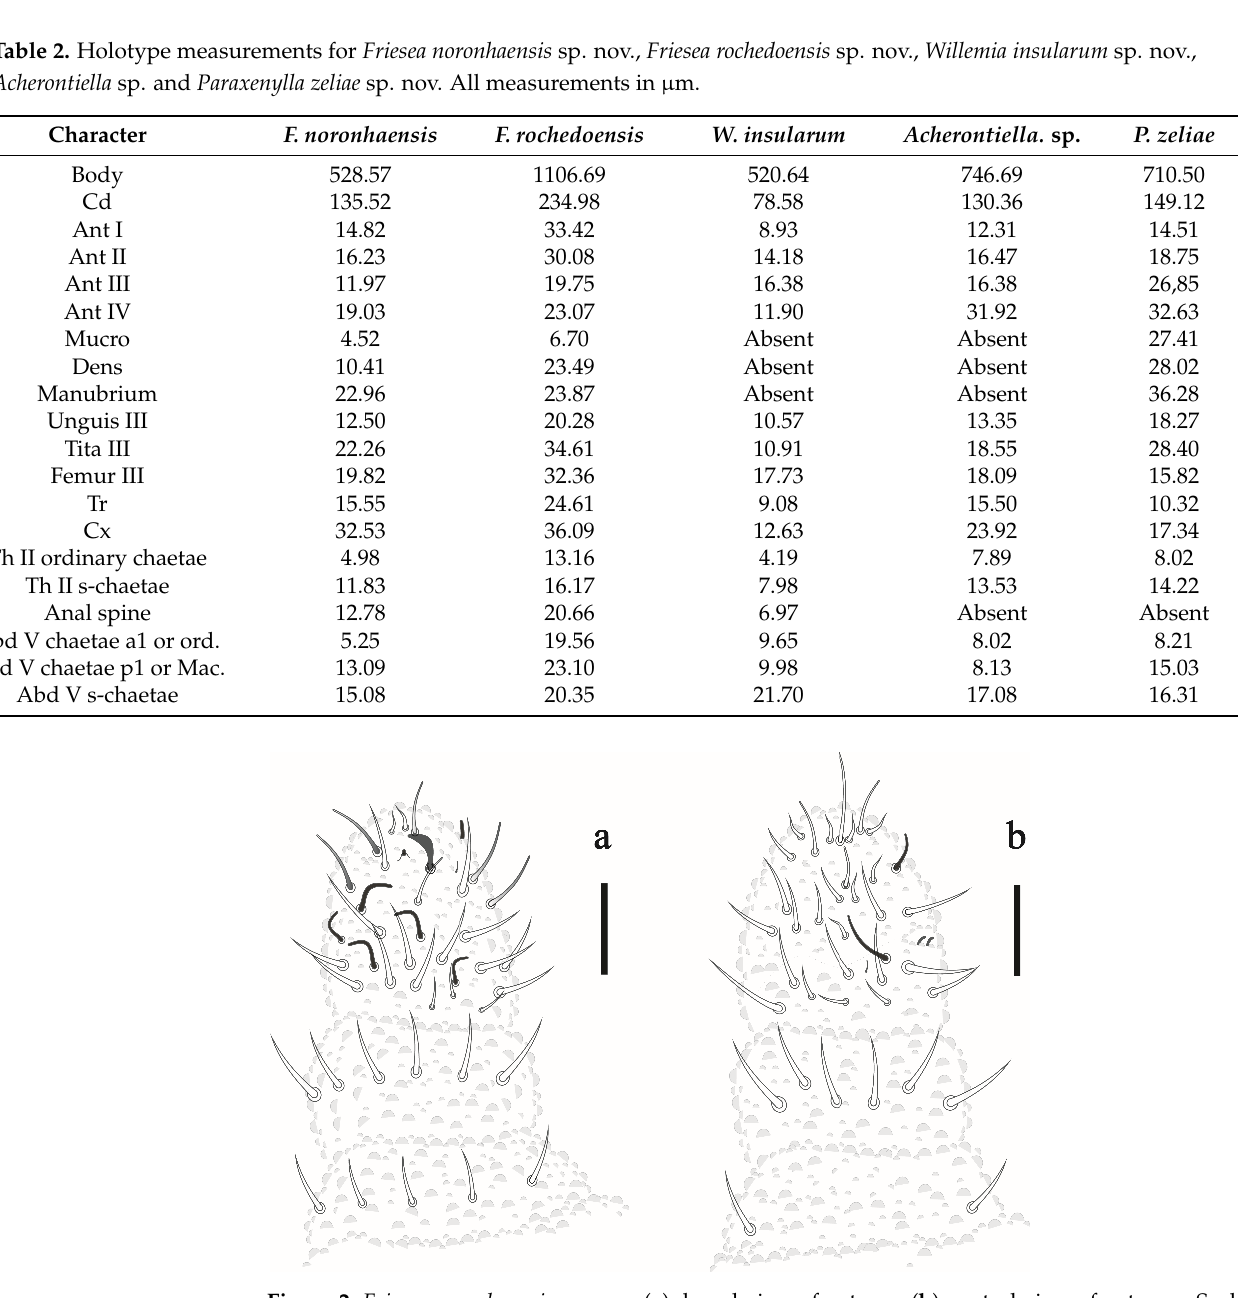
Figure 2. Friesea noronhaensis sp. nov. ( a ) dorsal view of antenna ( b ) ventral view of antenna. Scale bar: 10 µm.